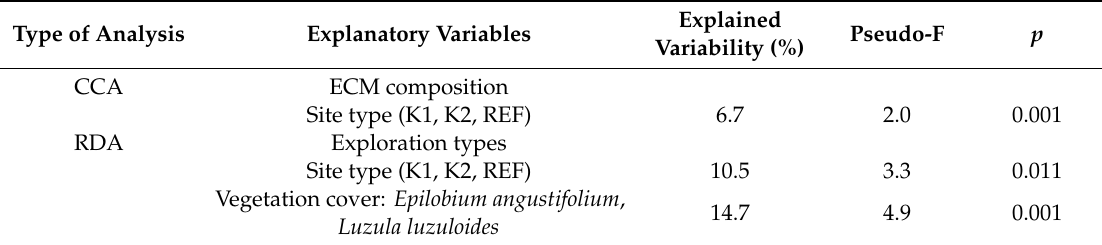
Table 2. E ff ect of environmental variables on ECM composition (canonical correspondence analysis (CCA)) and proportion of exploration types (redundancy analysis (RDA)) on Norway spruce seedlings in K1—forest attacked by bark beetle, K2—forest destroyed by bark beetle, and REF—mature forest. Type of